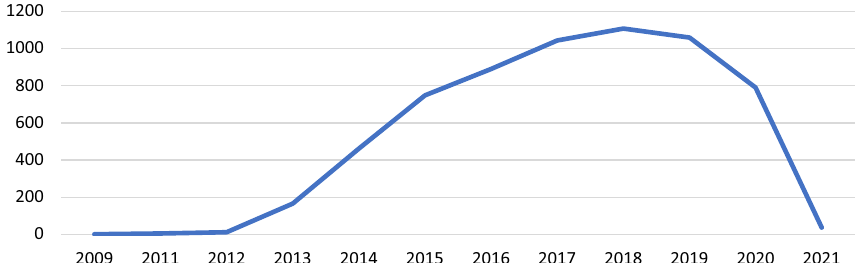
Fig. 2 Distribution of papers over the years (n